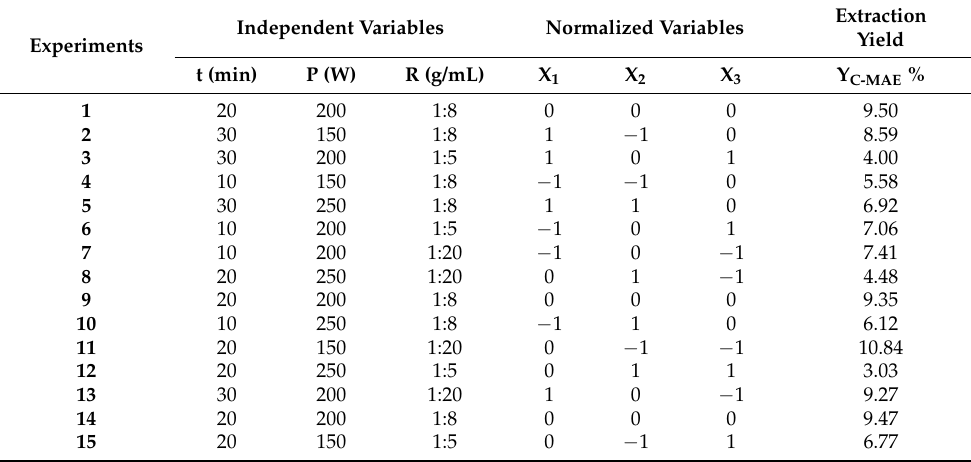
Table 1. Box-Behnken experimental design and operational conditions represented in accordance of dimensional and dimensionless independent variables t (time, min) (X 1 ); P (power, W) (X 2 ), R (ratio w / v , g/mL) (X 3 ) and experimental response (extraction yield by microwave-assisted extraction, Y C-MAE ).